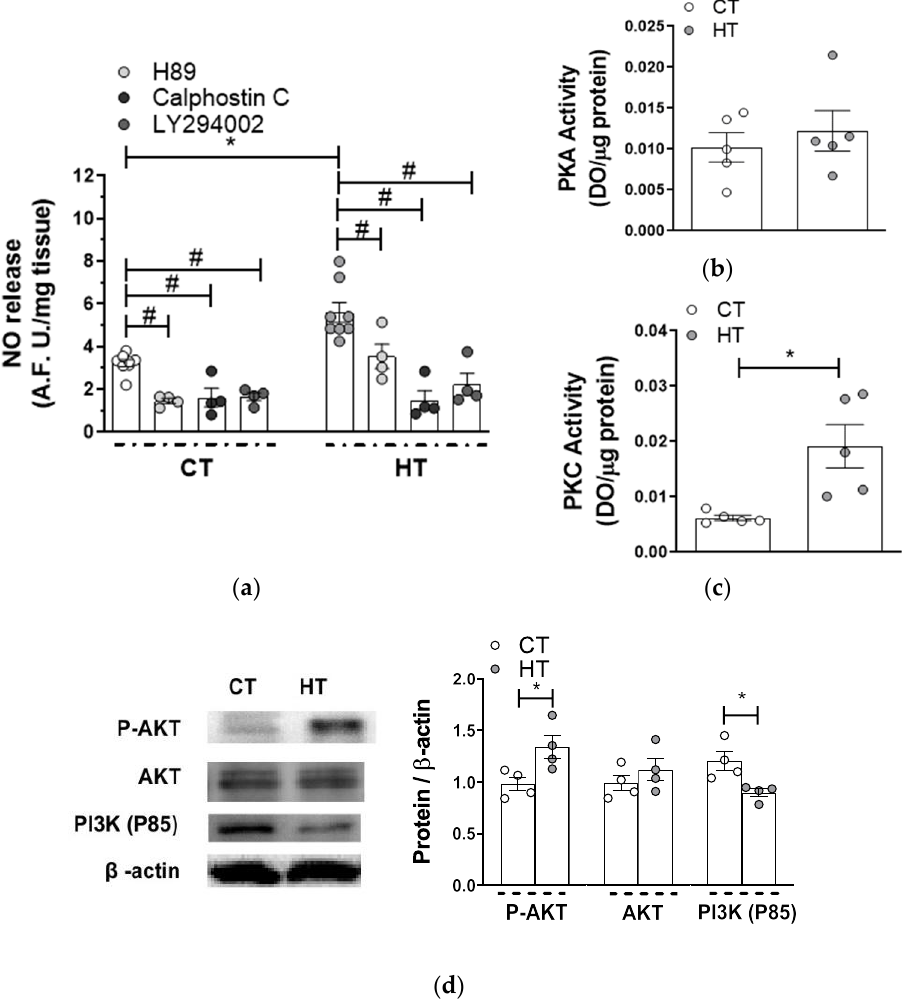
Figure 6. Figure 6. ( a ) Effect of preincubation with 1 µ mol/L H89 (a PKA inhibitor), 0.1 µ mol/L calphostin C (a PKC inhibitor) or 10 µ mol/L LY 294002 (a PI3K inhibitor) on EFS-induced NO release in mesenteric arteries from control (CT) and hyperthyroidic rats (HT). Data (Mean ± S.E.M.) are expressed as arbitrary fluorescence units/mg tissue. * p < 0.05 CT vs. HT (Student’s t -test). # p < 0.05 conditions without inhibitor vs. conditions with inhibitor in each group (Student’s t -test). n = 4–8 segments in each experimental group. ( b ) PKA activity, and ( c ) PKC activity in mesenteric arteries from CT and HT rats. Results are represented as optical density (OD) units/ µ g protein (mean ± S.E.M). n = 5 segments from different animals in each group. * p < 0.05 CT vs. HT (Student’s t -test). ( d ) Western blot analysis for total AKT (AKT), phosphorylated AKT at the T308 residue (P-AKT) and P85 subunit of PI3K in mesenteric arteries from CT and HT rats. Each lane is representative of 4 isolated arterial segments from different animals in each group. Right panel shows densitometry analyses of the protein expression. Results (mean ± S.E.M) are expressed as protein expression relative to β -actin expression. * p < 0.05 CT vs. HT (Student’s t